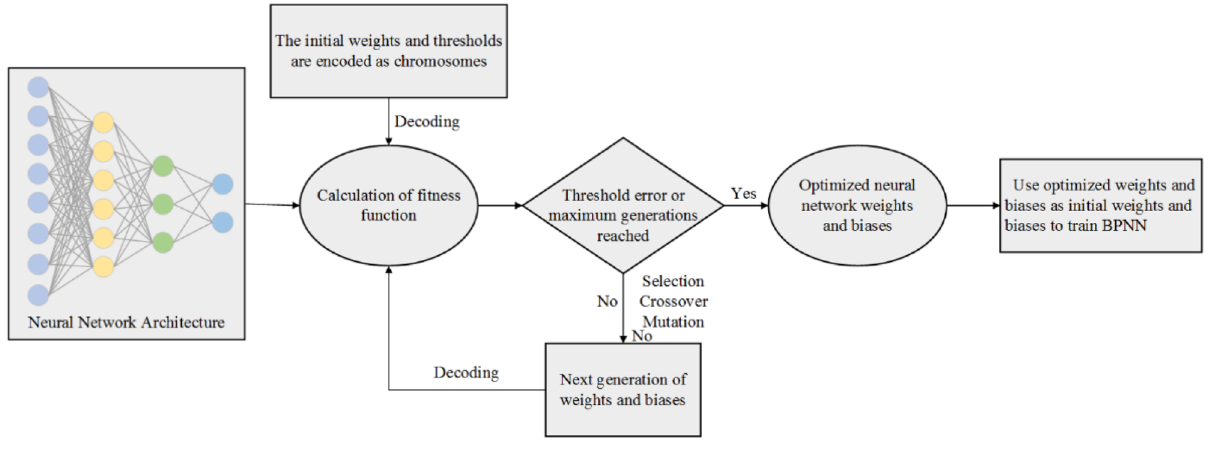
Figure 12. GA-BPNN flow